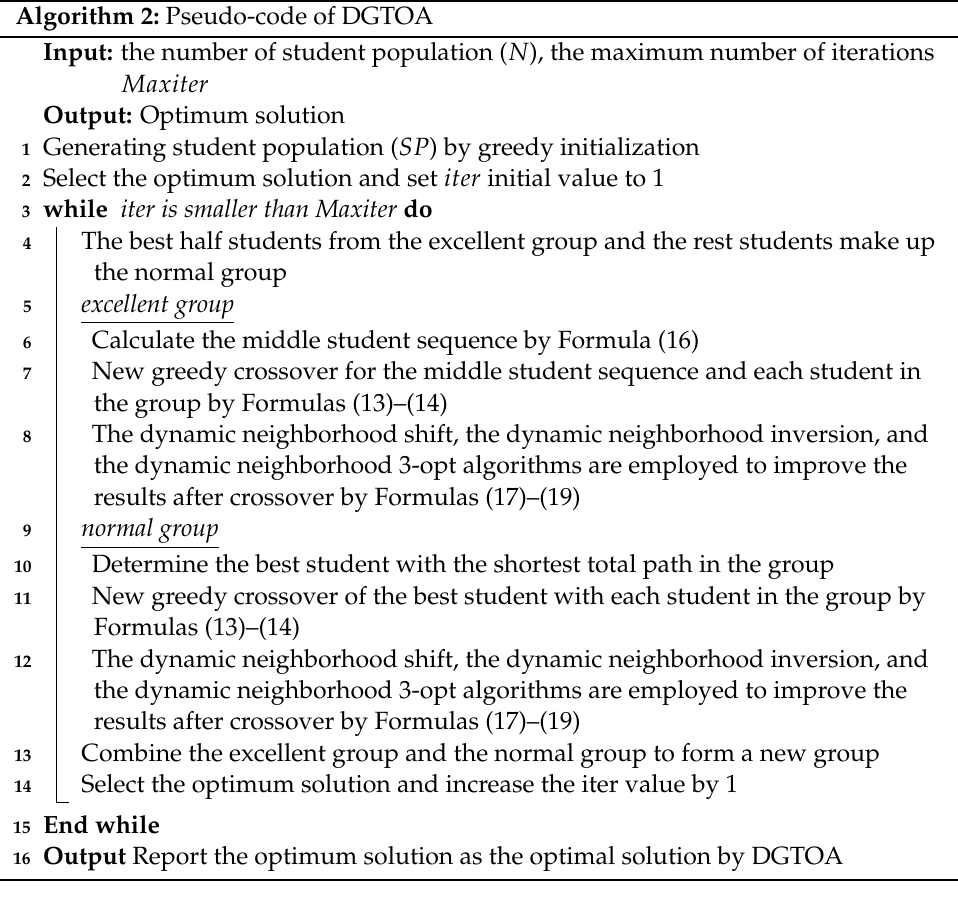
Algorithm 2: Pseudo-code of